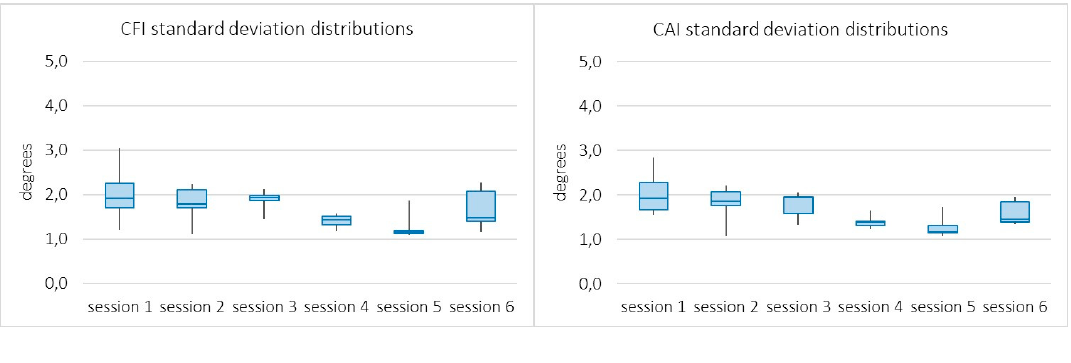
Figure 7. Box plots from distributions of the standard deviations of the Concentric Abduction Index ( a ) and the Concentric Flexion Index ( b ) across patients over the six sessions.